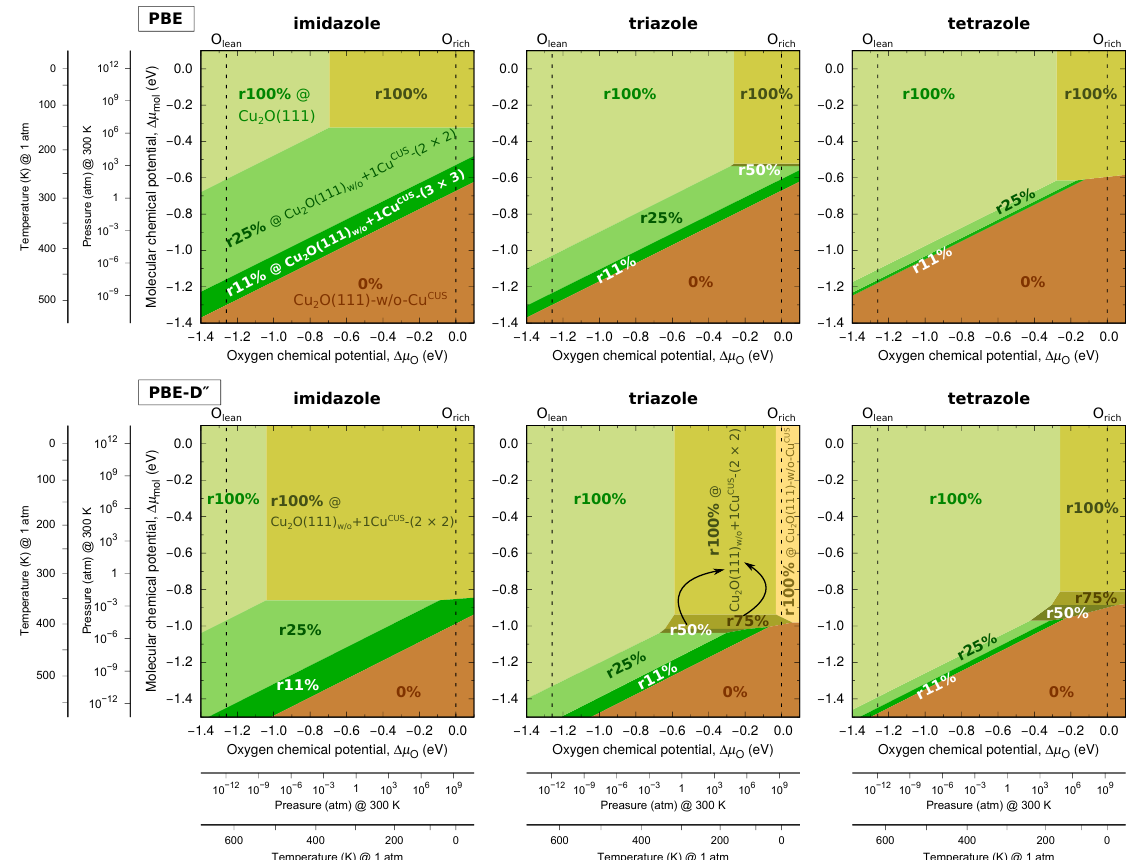
Figure 7. Two-dimensional phase diagrams as a function of azole and oxygen chemical potentials, ˜ γ ads ( µ O , µ MolH ) , for imidazole ( left ), triazole ( middle ), and tetrazole ( right ) on Cu 2 O(111)-type surfaces, calculated with PBE ( top row) and PBE-D (cid:48)(cid:48) ( bottom row) functionals. Top-view snapshots of structures appearing on the phase diagrams are shown in Figure 8. The dependence on each chemical potential was also recast into a temperature scale at partial pressure p = 1 atm and into a partial pressure scale at T = 300 K (shown by two additional axes for each chemical